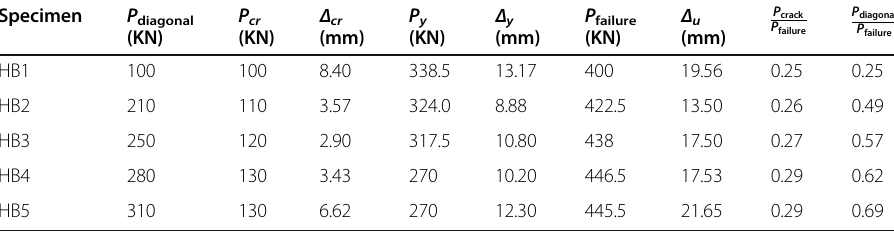
Table 7 Experimental results of tested beams Specimen